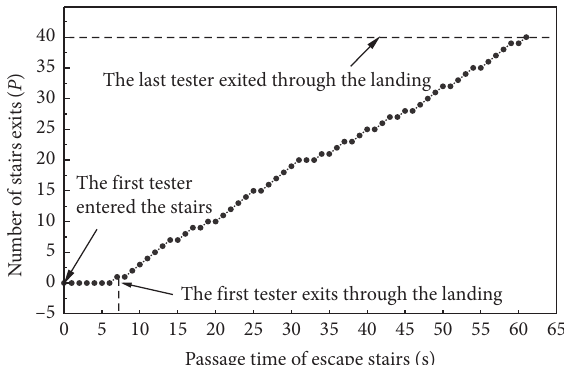
Figure 9: Curve of staircase passing time with the exit passing number (under 50m staircases